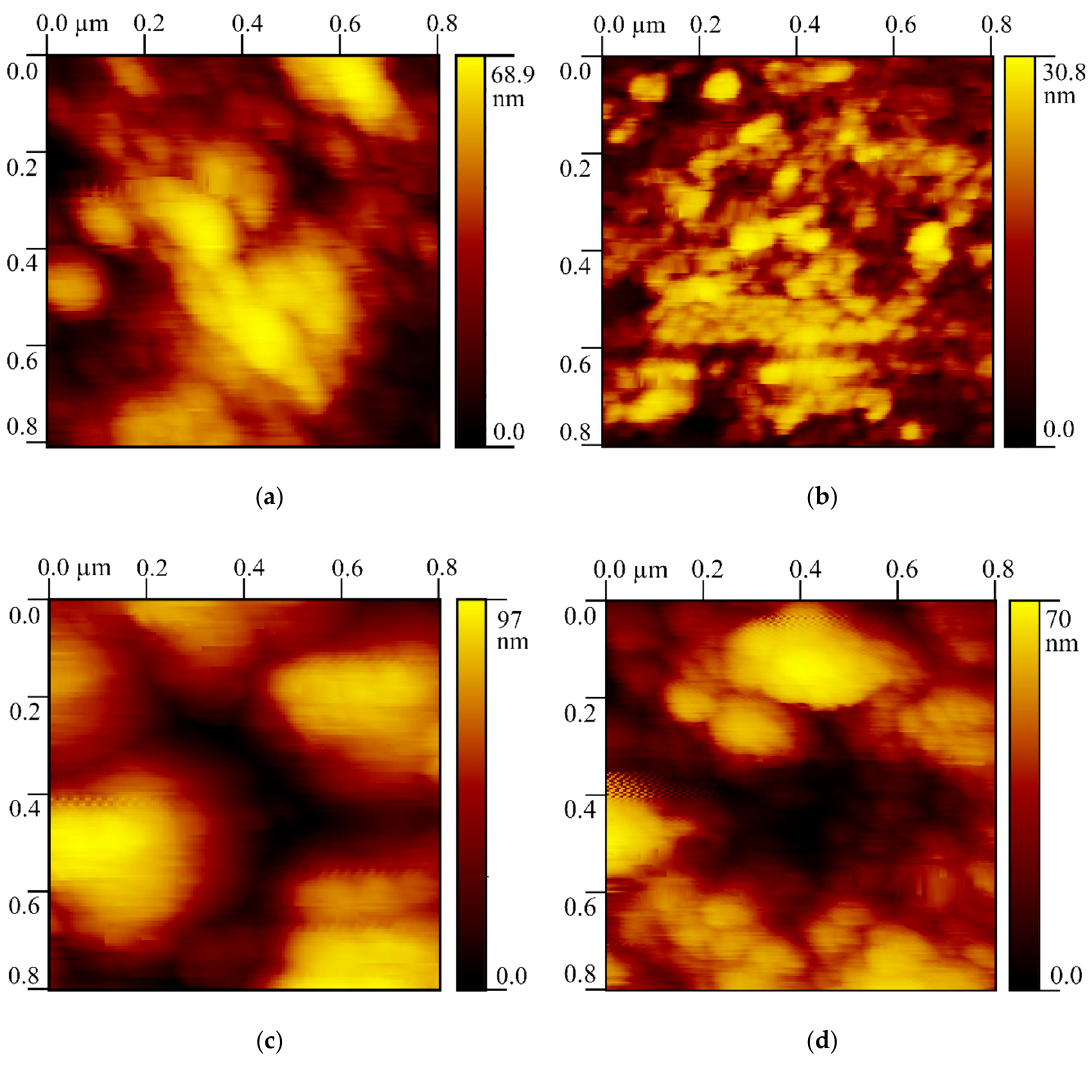
Figure 5. Surface topography of the tooth areas: ( a ) natural enamel WSL; ( b ) area of sound enamel on the opposite medial side of the tooth; ( c ) dentine bordering the WSL; ( d ) dentine bordering the area of sound enamel. Table 3. Surface roughness of the tooth areas.